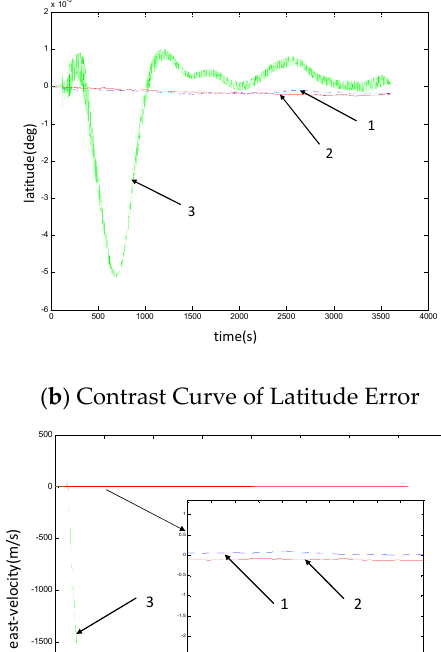
( d ) Contrast Curve of east-velocity Error